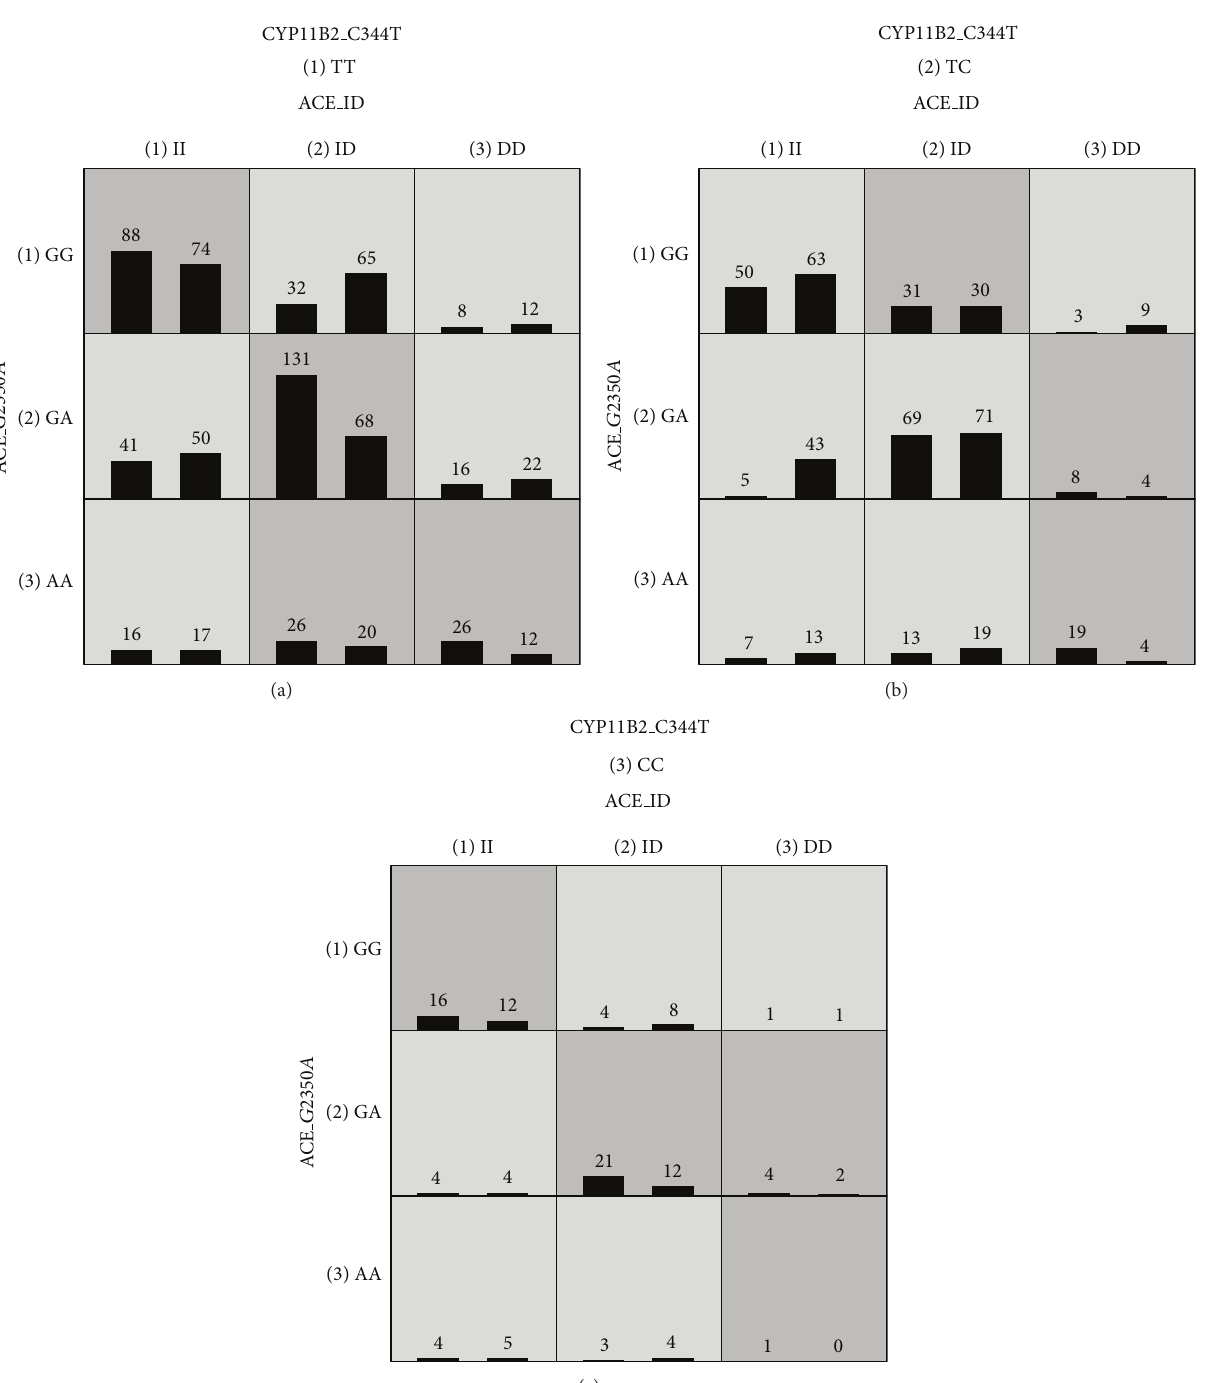
Figure 1: The distribution of cases (left bars) and controls (right bars) for each genotype combination from the three SNPs (ACE I/D, ACE G2350A, and CYP11B2 C-344T) identified in the overall best model by MDR analysis.